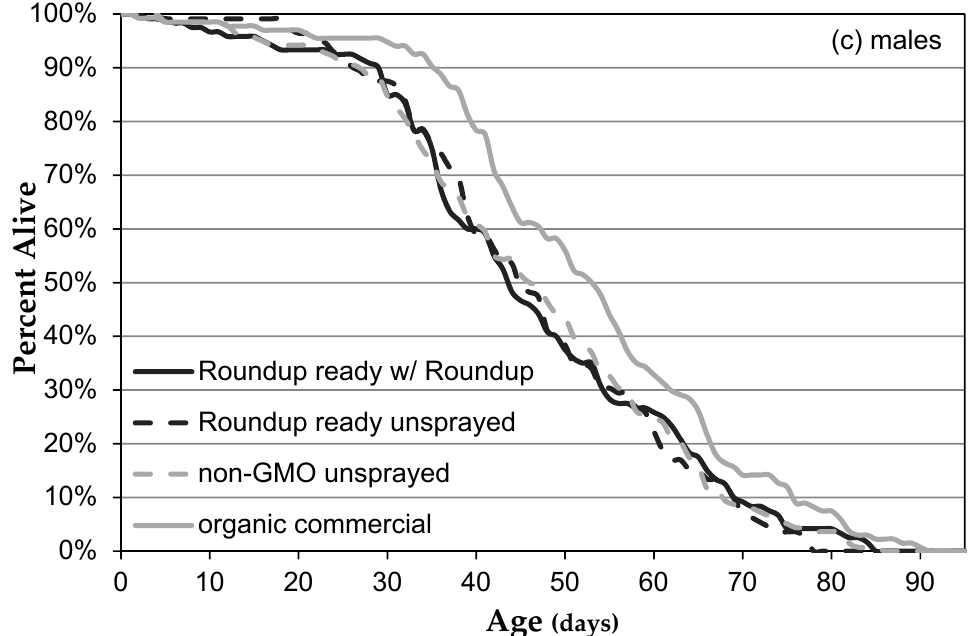
Figure 1. Lifespan of Drosophila exposed to diets containing different types of corn. ( a ) Lifespan (± standard error) of males ( △ ) and females ( ● ) for each diet treatment. ( b , c ) Time course of mortality for females ( b ) and males ( c ) on each diet treatment.